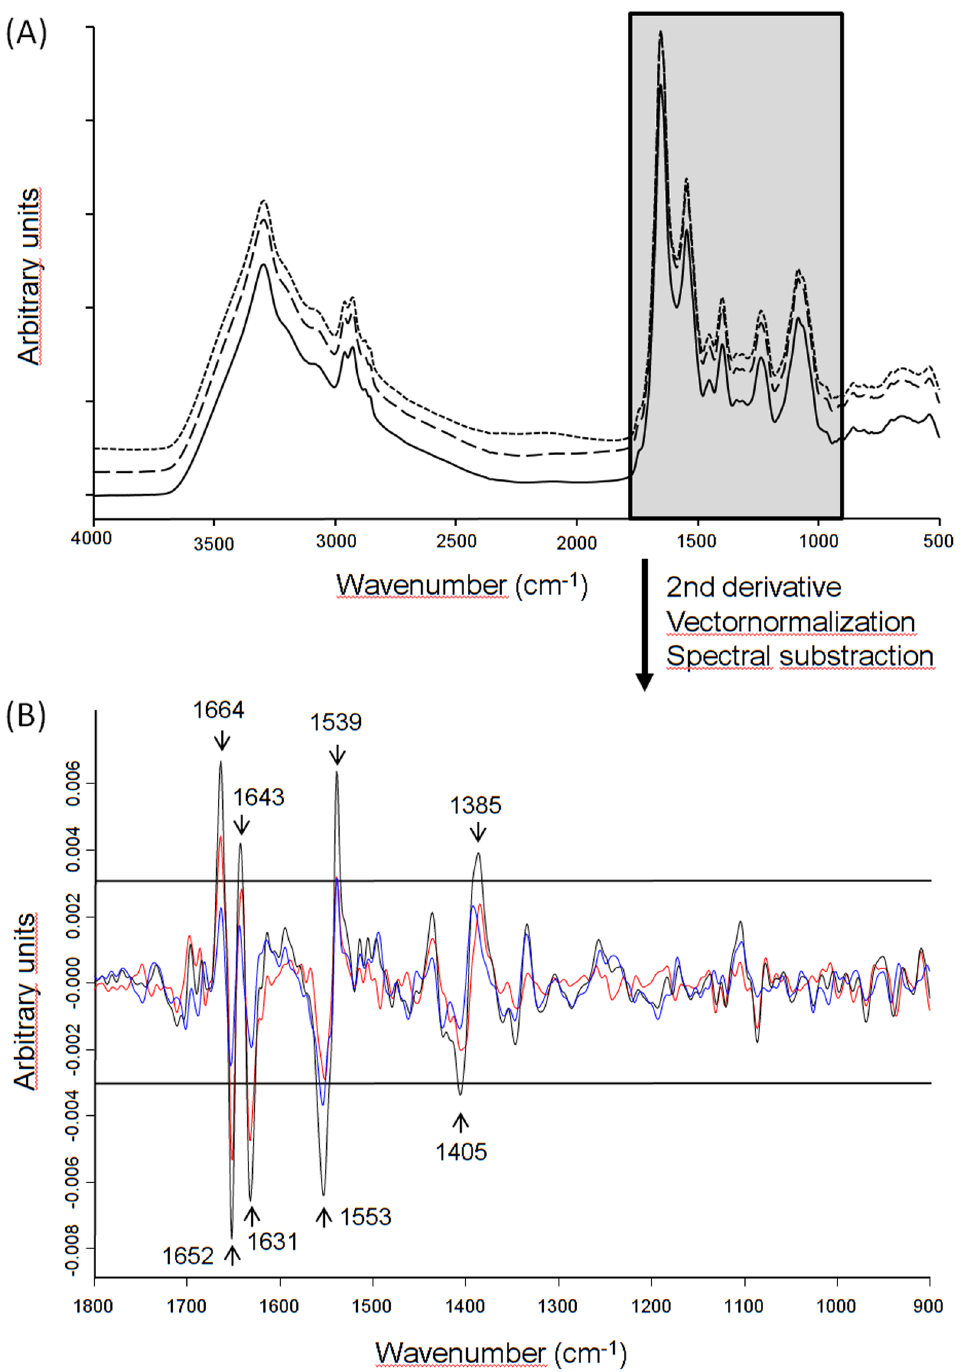
Fig. 2. FTIR spectra of L. monocytogenes re-isolated from challenged mice. (A) Average FTIR spectra derived from 129/Sv (dotted), Tyk2 2 / 2 (dashed) and C57BL/6 (solid) isolates are shown from the whole spectral range (B) Subtraction spectra were generated from second derivative, vector-normalized, average FTIR spectra of the three different mouse genotypes. Spectra from C57BL/6 mice were subtracted from 129/Sv isolates (black), spectra from C57BL/6 mice were subtracted from Tyk2 2 / 2 (red) and spectra from Tyk2 2 / 2 were subtracted from 129/Sv isolates (blue). Most pronounced differences were observed in the spectral range of 1700–1500 cm 2 1 (protein region) and can be assigned to amide I (1670–1625 cm 2 1 ) and amide II (1560– 1530 cm 2 1 ).